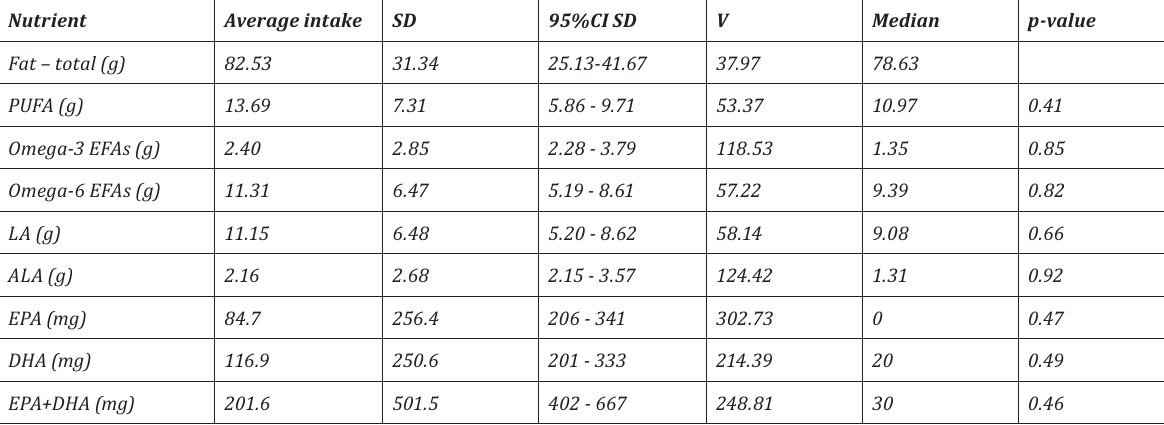
Table 5. Fat intake in the examined population